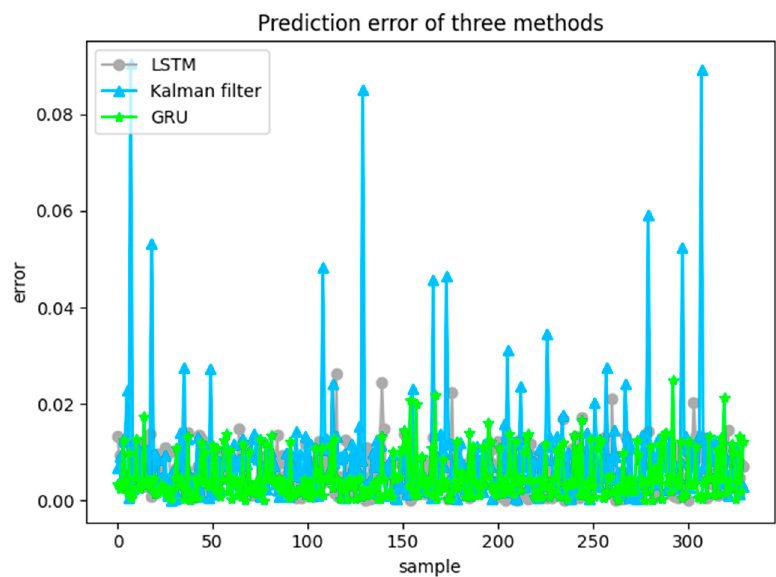
Figure 18. Prediction errors of the three methods calculated by equation (25): gray solid circle markers indicate the prediction results of LSTM, blue solid triangle indicate those of EKF, and the green solid stars markers denote those of GRU model.